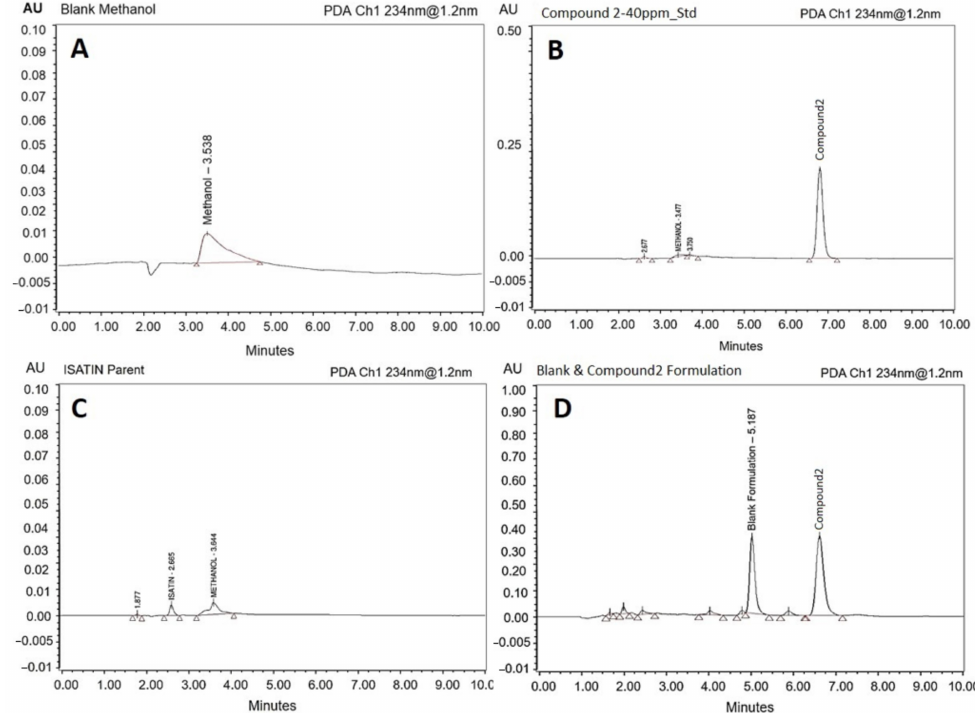
Figure 3. The representative UHPLC chromatograms of the blank methanol sample ( A ), standard solution of compound ( 2 ) (model drug), conc. 40 µ g/mL ( B ), standard solution of isatin (parent drug), conc. 5 µ g/mL ( C ) and blank lipid formulation and compound ( 2 ) containing lipid formulation sample ( D